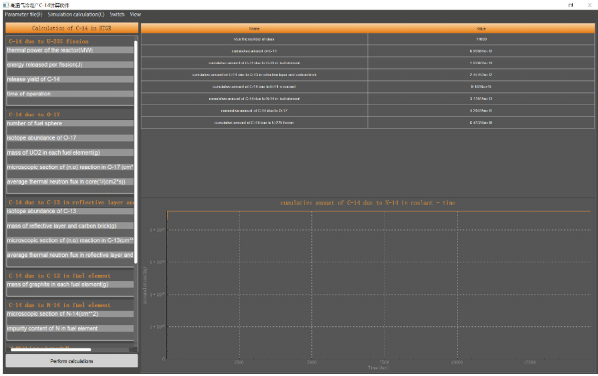
Figure 5: HTR-STAC visual interface.